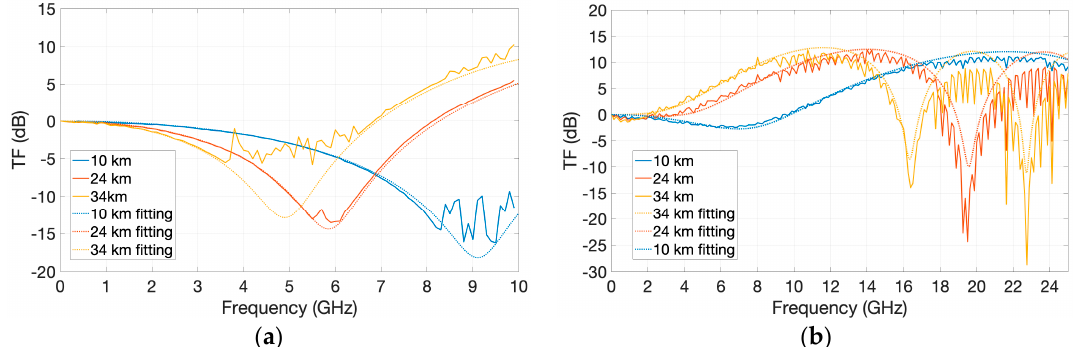
Figure 1. Experimental setup for chirp parameters measurement.